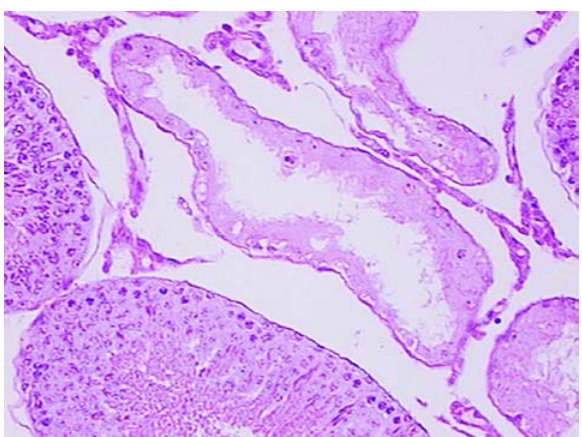
Figure 1 – Photomicrography of a transversal section of the tes- tis, showing degenerated seminiferous tubules (HE, X